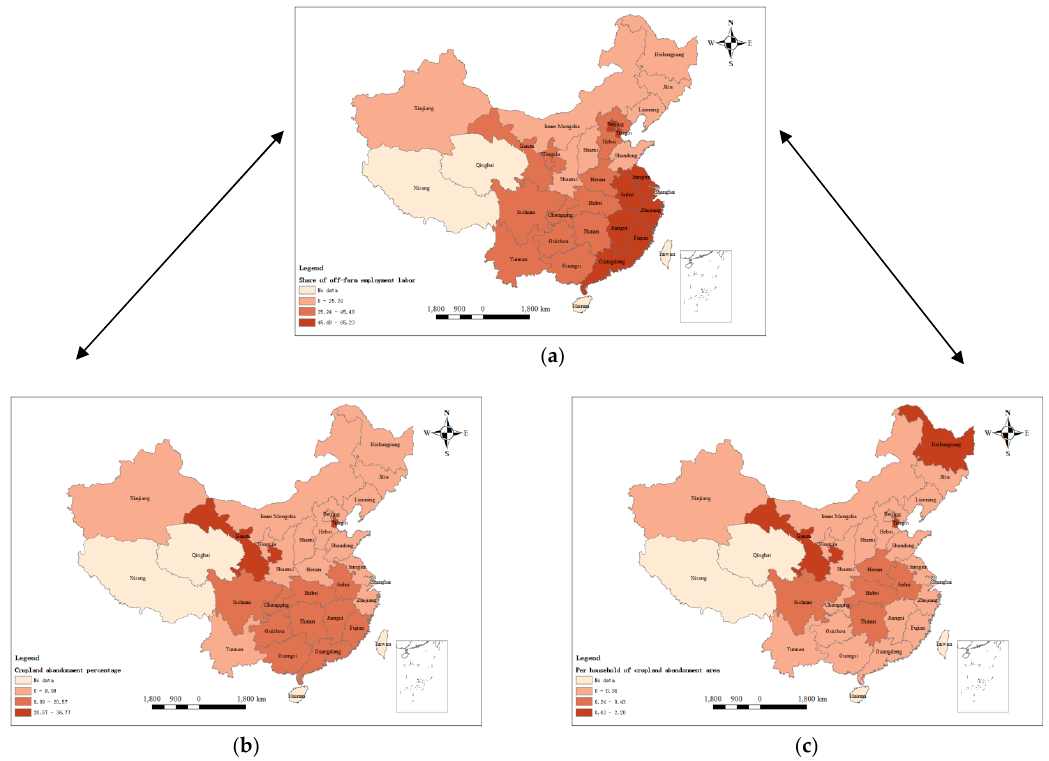
Figure 2. ( a ) Off-farm employment percentage; ( b ) Cropland abandonment percentage; ( c ) Cropland abandonment area.